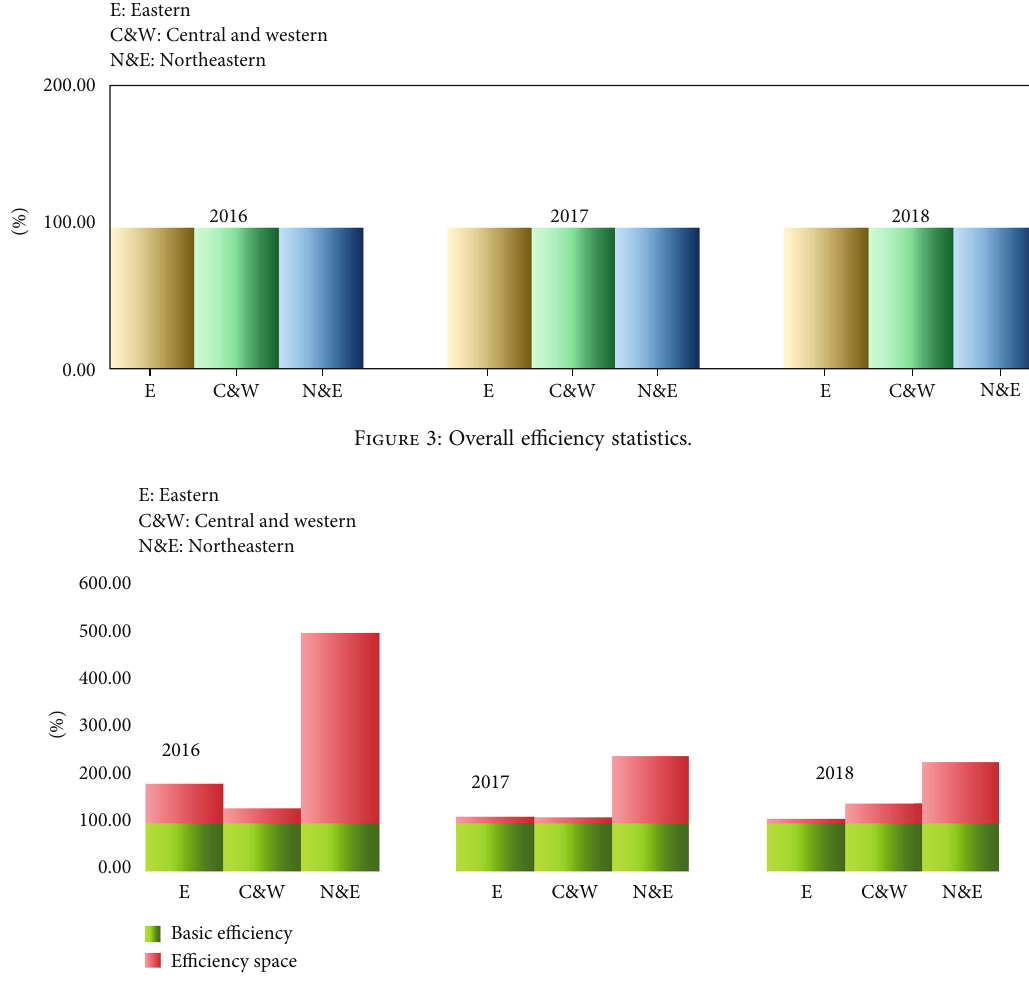
Figure 4: E ffi ciency space analysis.